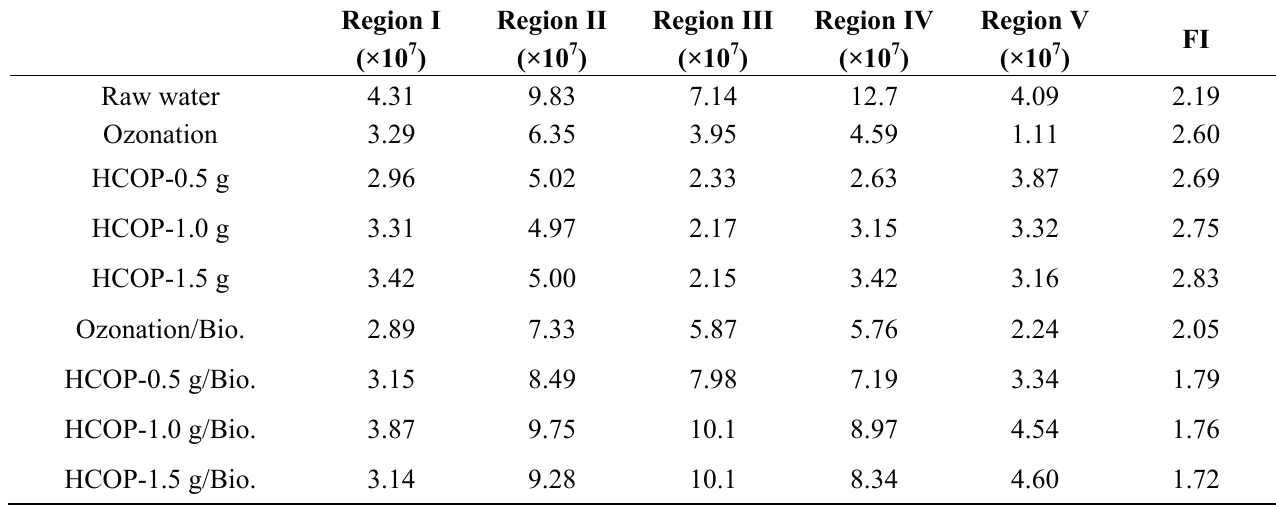
Table 2. Normalized excitation-emission area volumes ( ϕ (FI) of the individual regions in the EEM spectra. FI, fluorescence